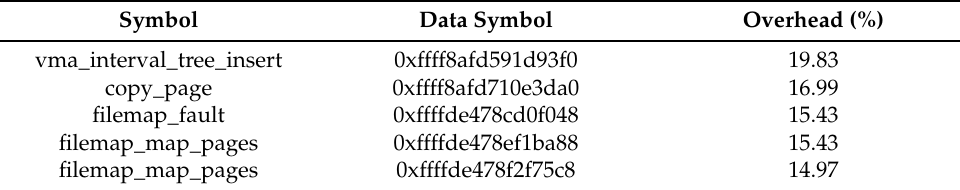
Table 5. Legit RSA decryption program detection results of Mem-loads.